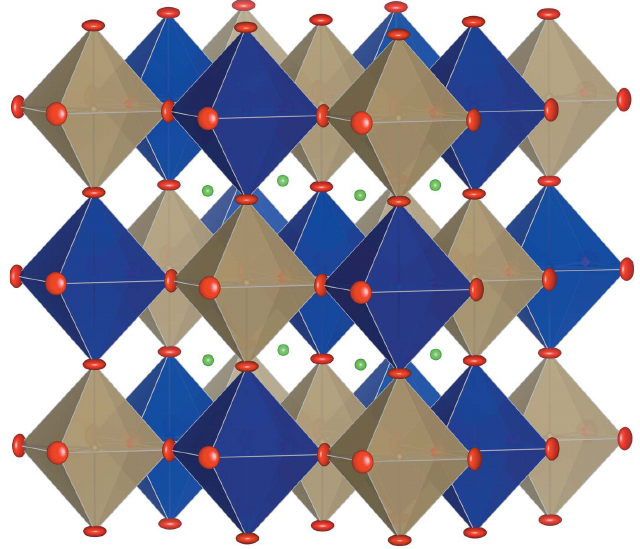
Figure 1 Displacement ellipsoid (probability 50%) and polyhedron view of the cubic double-perovskite Sr 2 Cr 0.84 Ni 0.09 Os 1.07 O 6 . Blue and light-brown polyhedra are CrO 6 and OsO 6 , respectively. Red and green ellipsoids are oxygen and Sr, respectively. Figure drawn using VESTA (Momma & Izumi, 2011).